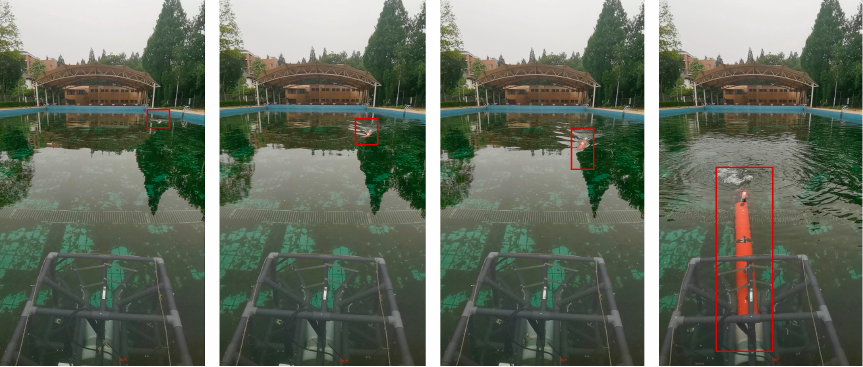
Figure 20. Picture sequence of the AUV docking process.